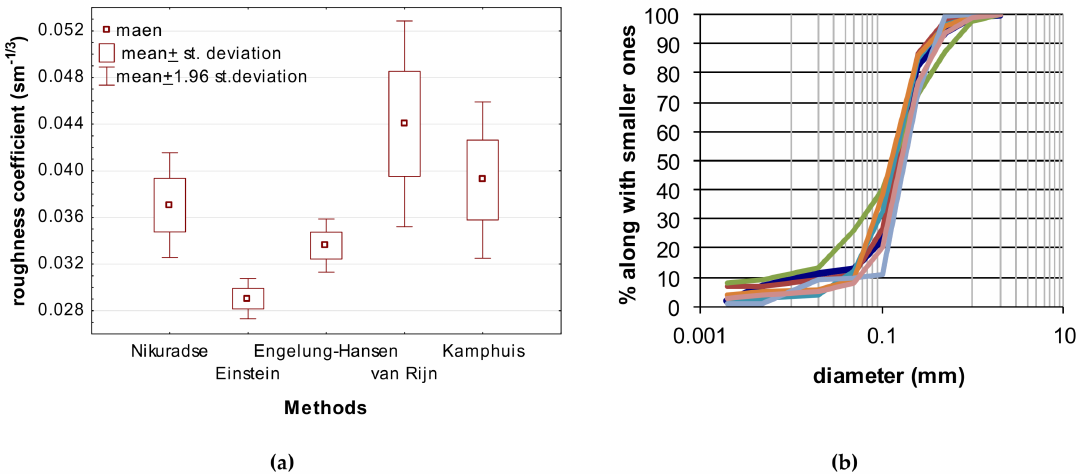
Figure 7. Estimation of roughness coefficients: ( a ) Statistics of roughness coefficients calculated on the basis of approaches presented in Table 1; ( b ) sieve curves applied for the calculation of roughness